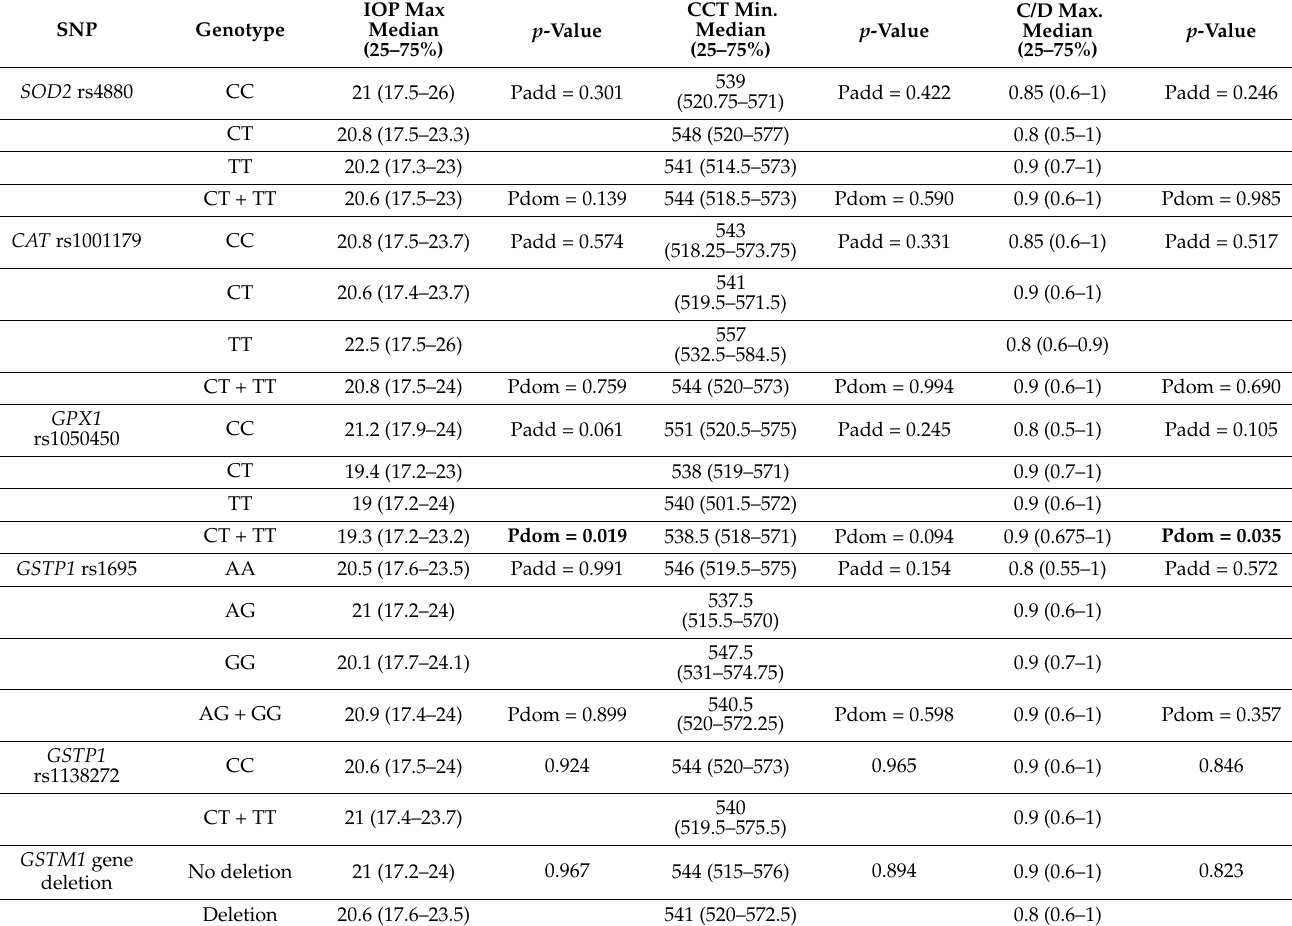
Table 5. Association of investigated polymorphisms with the IOP, CCT and C/D